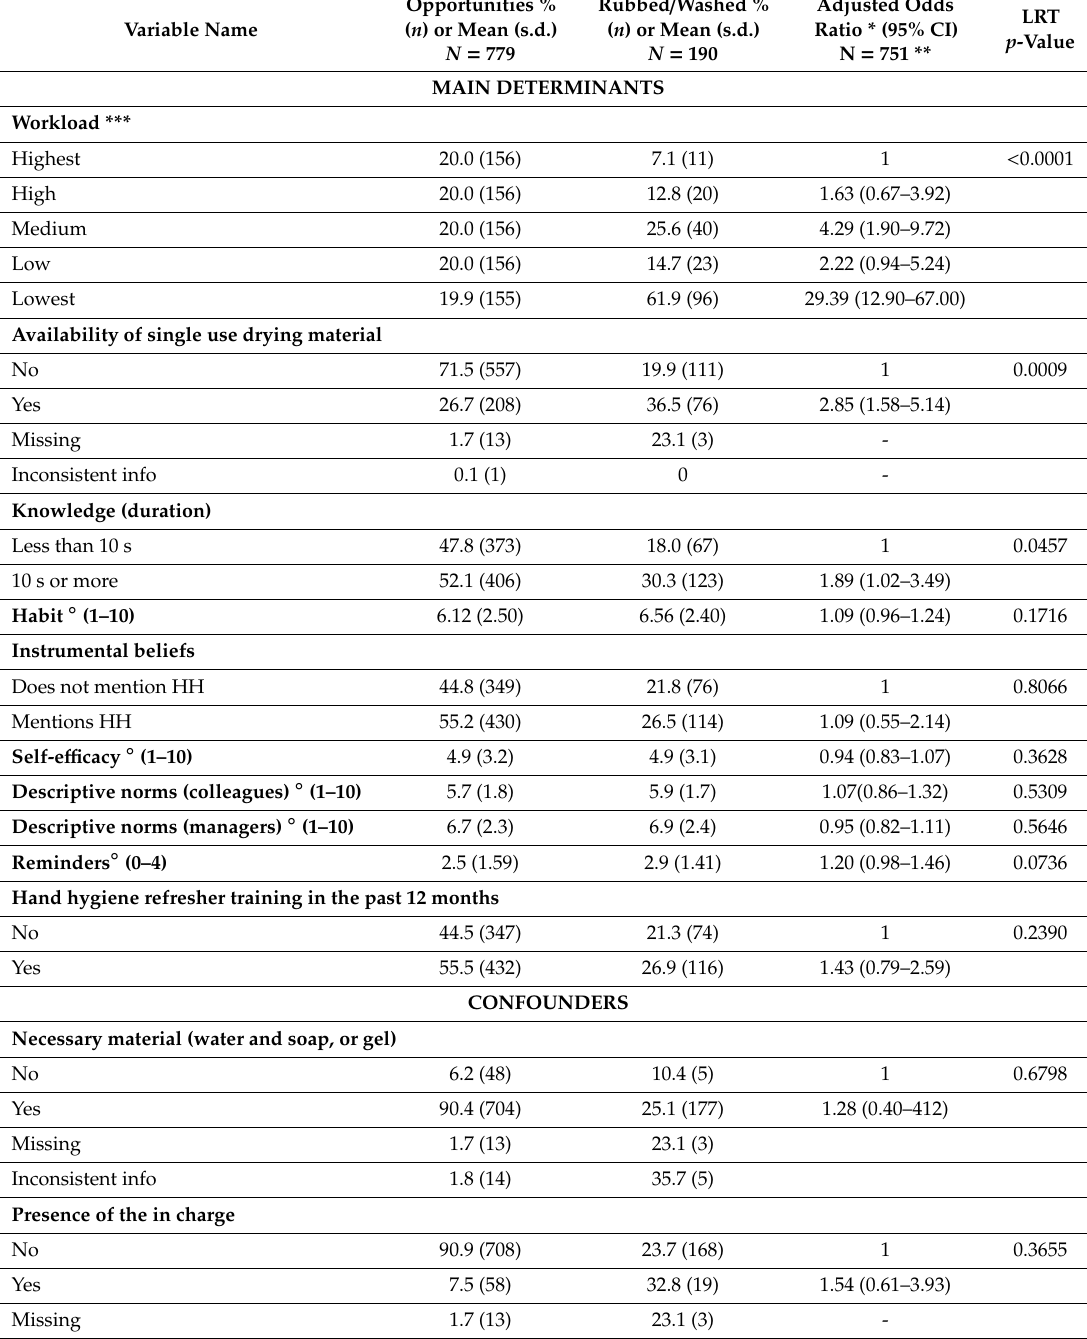
Table 3. Descriptive characteristics of the sample and adjusted odds ratio (Model 1) for the association between each modifiable determinants and hand rubbing /